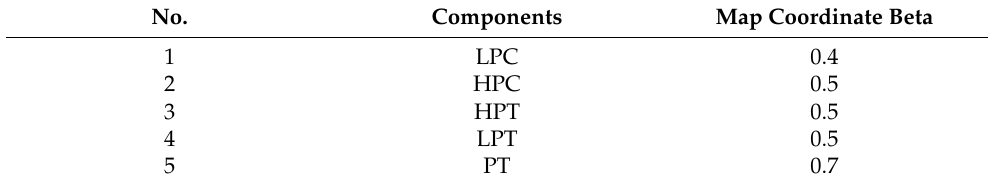
Table 5. Map coordinate